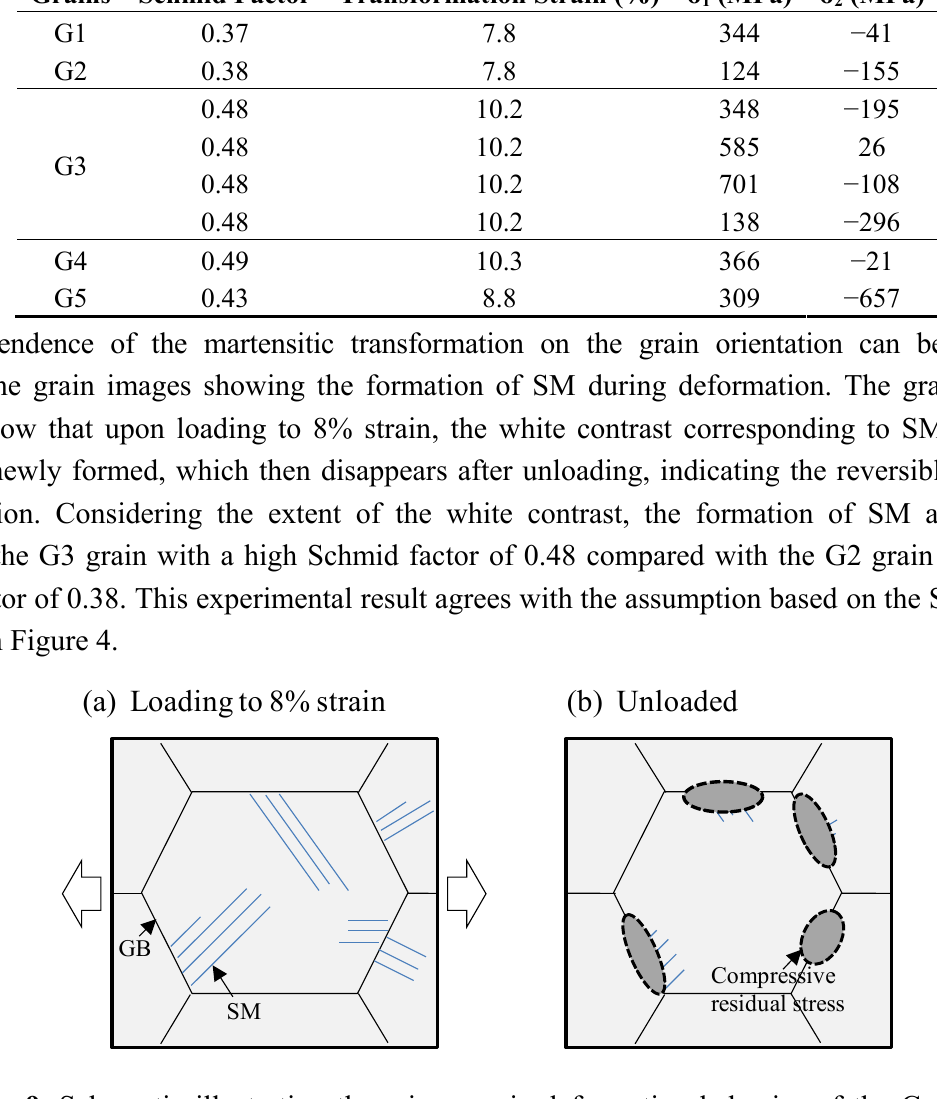
Figure 9. Schematic illustrating the microscopic deformation behavior of the Cu-Al-Mn sample ( a ) during loading to 8% strain and ( b ) after